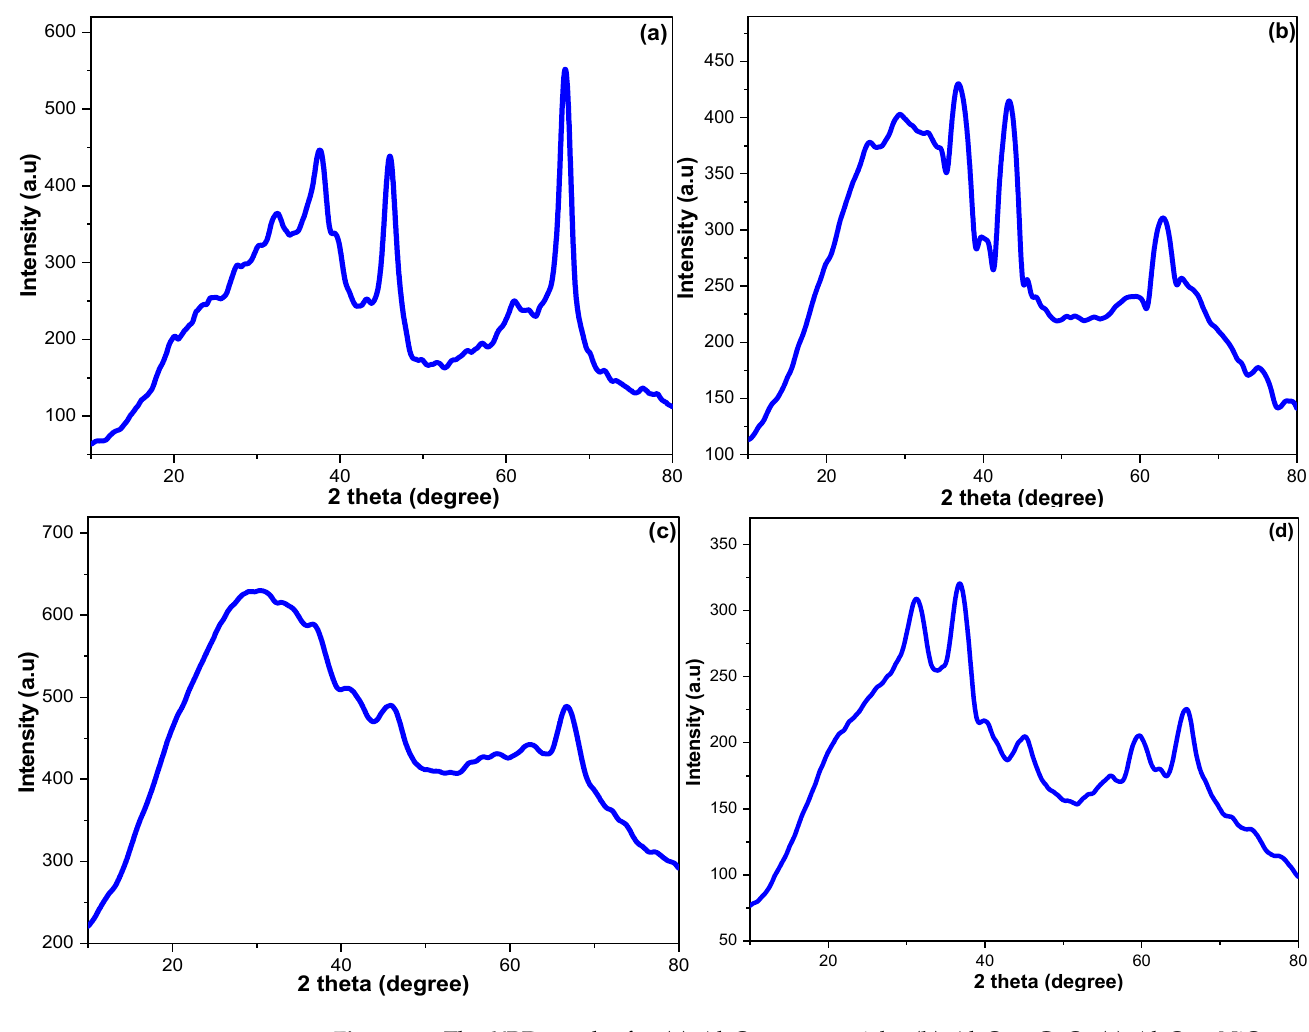
Figure 4. The XRD results for ( a ) Al 2 O 3 nanoparticle, ( b ) Al 2 O 3 —CuO, ( c ) Al 2 O 3 —NiO, and ( d ) Al 2 O 3 —CoO nanocomposites.